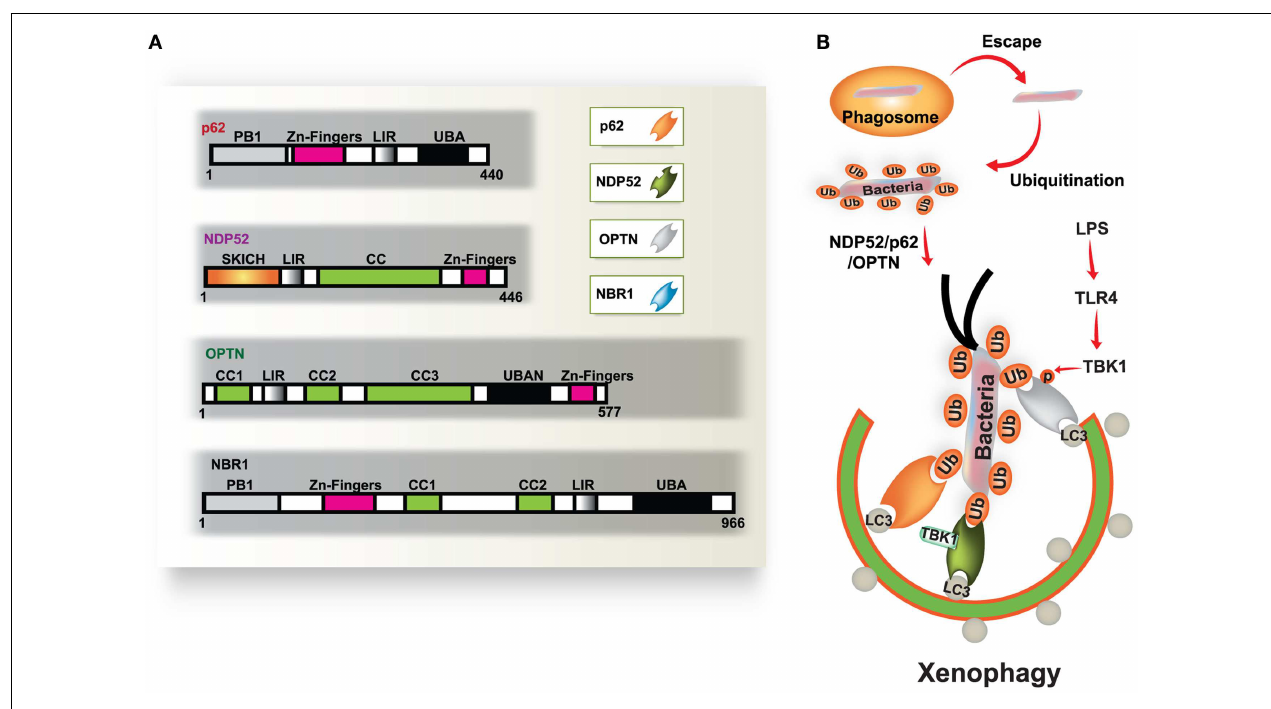
from SCVs are recognized and ubiquitinated for recruitment to p62, NDP52, and OPTN, which results in their transportation to the phagophore. NDP52 interacts with LC3C through its CLIR domain, inducing antibacterial autophagy.TBK-1 activated byTLR4 induces phosphorylation of OPTN at Ser177, which leads to enhanced binding affinity for LC3. Moreover,TBK-1 is involved in the activation of NDP52-mediated autophagy (right). CC, coiled coil domain; PB1, Phox and Bem1p domain; UBD, ubiquitin binding